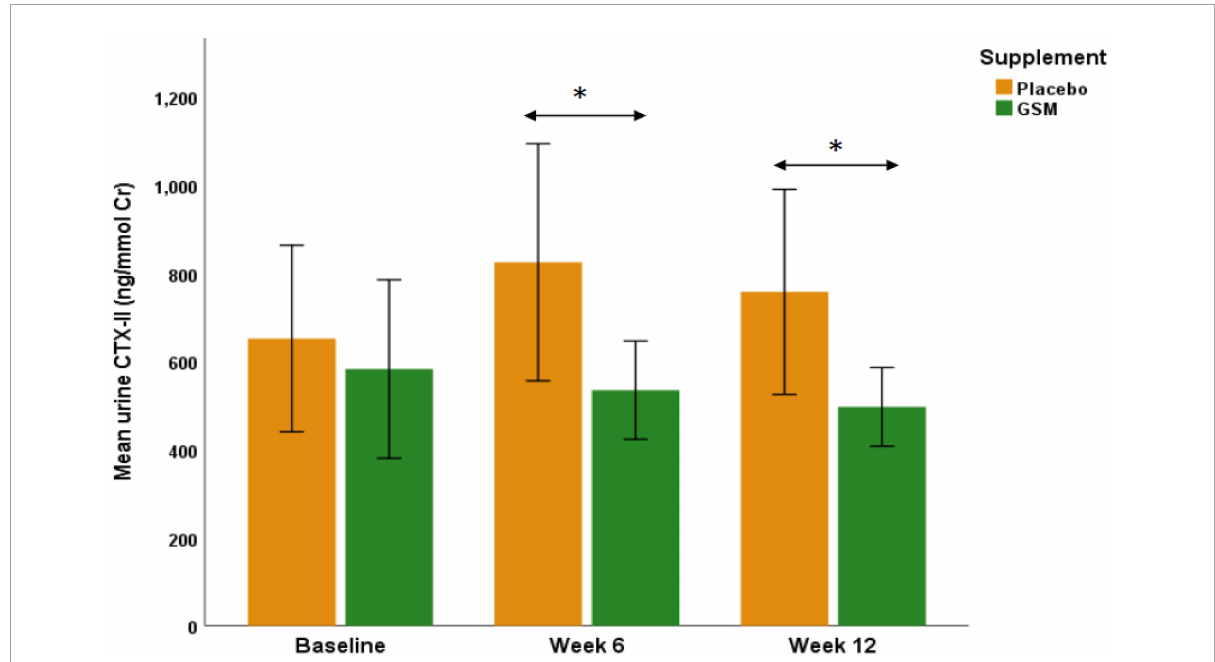
FIGURE3 The urinary C-telopeptide of type II collagen (CTX-II) levels in those subjects with knee injury and osteoarthritis outcome score (KOOS) domain score of 86 or below in GSM group ( n = 21) and placebo ( n = 18). There was a significant difference between groups as urinary CTX-II was significantly lower in GSM compared to placebo at week 6 ( P = 0.04) and week 12 ( P = 0.03). The values are expressed at mean ± standard error and compared by Student’s t -test at each time point. *Indicates the significance ( P < 0.05).